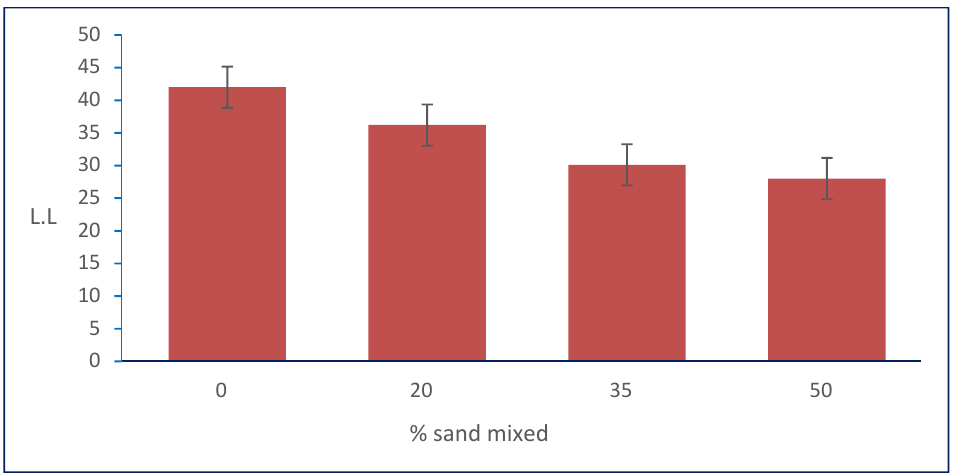
Figure 9. Effect of sand on LL.